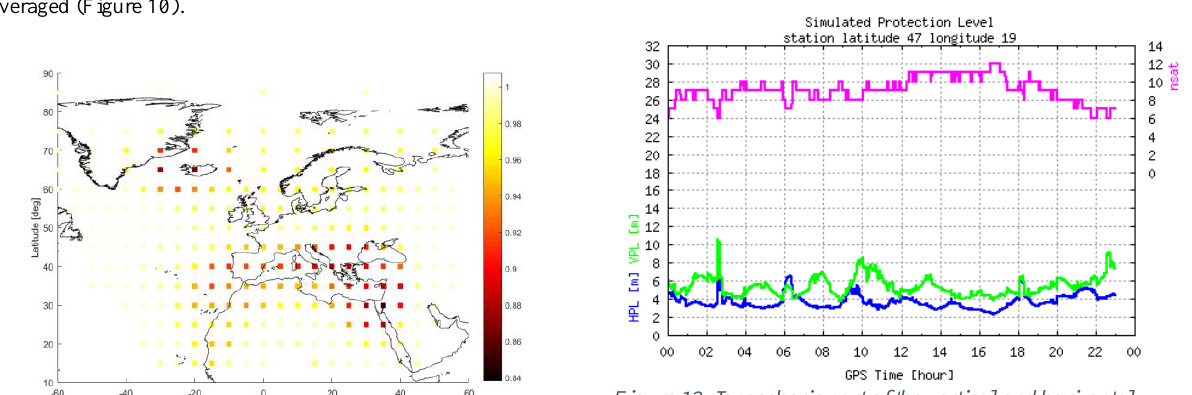
Figure 12 . Ionospheric part of the vertical and horizontal Protection Level with the number of satellites. The simulated site is in Budapest on 20/08/2018